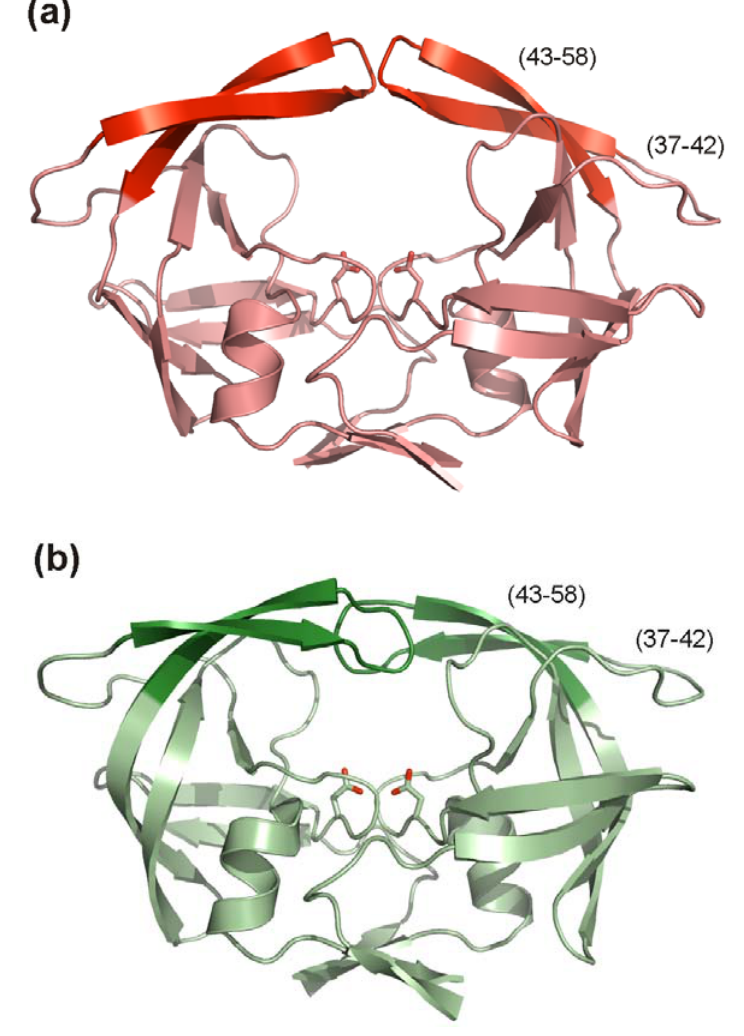
Figure 9. HIV PR flap conformations. (a) Overall structure of the apo-form of the HIV PR. The flaps (residues 43-58) in semi-open conformation are highlighted in red, residues 37-42, so called flap elbows are also indicated. The figure was generated using the structure of free HIV-1 PR (PDB code 1HHP [145]) and program PyMol [9]. (b) Overall structure of the HIV PR with flaps (in dark green) in closed conformation. Residues 37-42, so called flap elbows are also indicated. Inhibitor bound in the enzyme active site is omitted from the figure. The figure was generated using the structure of a highly